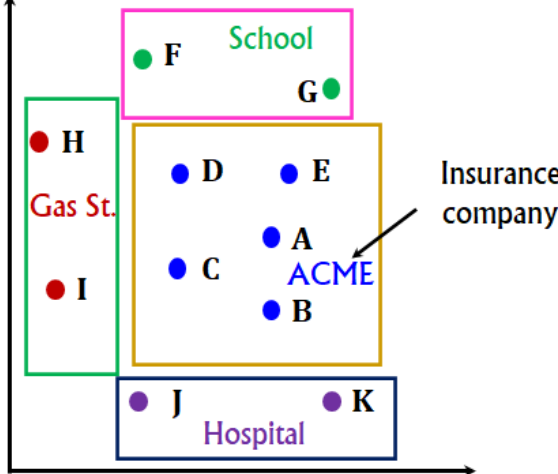
Figure 11. Overview of group privacy breach via movement boundary